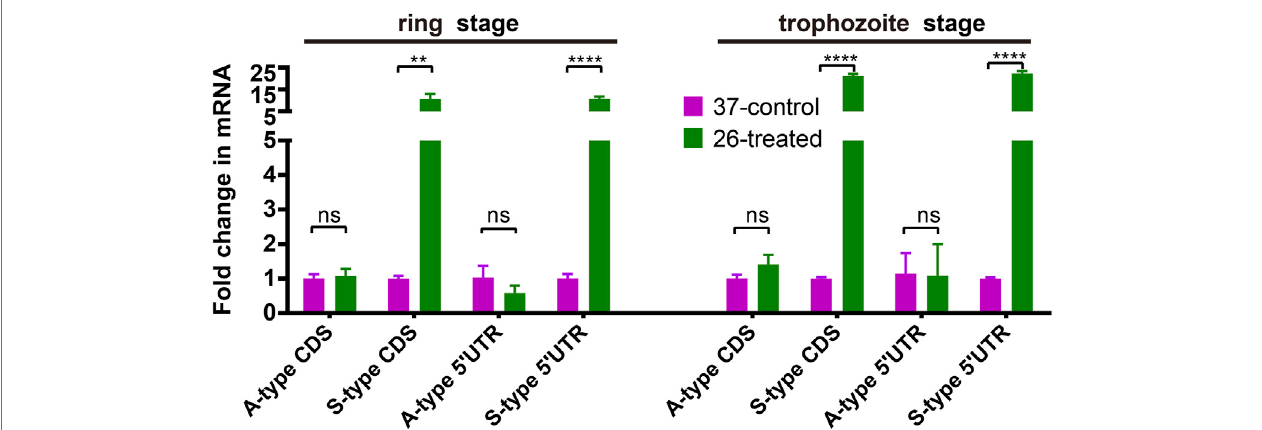
FIGURE2| TheeffectoftemperatureontheexpressionofA-andS-type18SribosomalRNA(18SrRNA).Foldchangesintheexpressionof18SribosomalRNAin the 26 ° C treatment group was detected by qRT-PCR. qPCR analyses of transcriptional regulation of A- and S-type 18S rRNA (fold changes of 3 h at 26 ° C to 37 ° C temperature stimulation) at 45/70 h after invasion (ring stage/trophozoite stage). Stages of parasites (ring stage or trophozoite stage) is shown at the top. Serine – tRNA ligase(PF3D7_0717700),ahousekeepinggene,wasusedtonormalizetheleveloftranscriptionofeachgene.Eachtypeof18SrRNAwasdetectedbytwopairsof primers ( Supplementary Table S2 ) located at different sites of transcriptions (5 ′ -UTR and CDS region). The name of each gene is shown at the bottom. The data are representative of three independent experiments. Two-sided t -test, *** p < 0.001; **** p < 0.0001; ns, no signi fi cance ( t -test; SDs from three replicates).